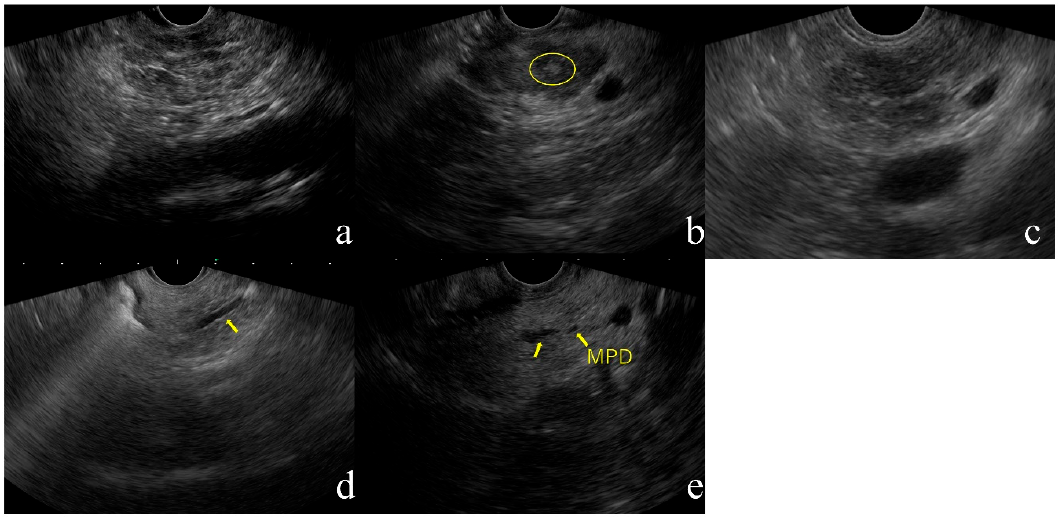
Figure 1. Diagnostic flowchart of CP in JPS guideline 2019. Abbreviations, CP, chronic pancreatitis; JPS, Japan Pancreas Society. ( a ) Lobularity, ( b ) Hyperechoic foci without shadowing, ( c ) Strands, ( d ) Hyperechoic MPD margin, ( e ) Dilated side branches